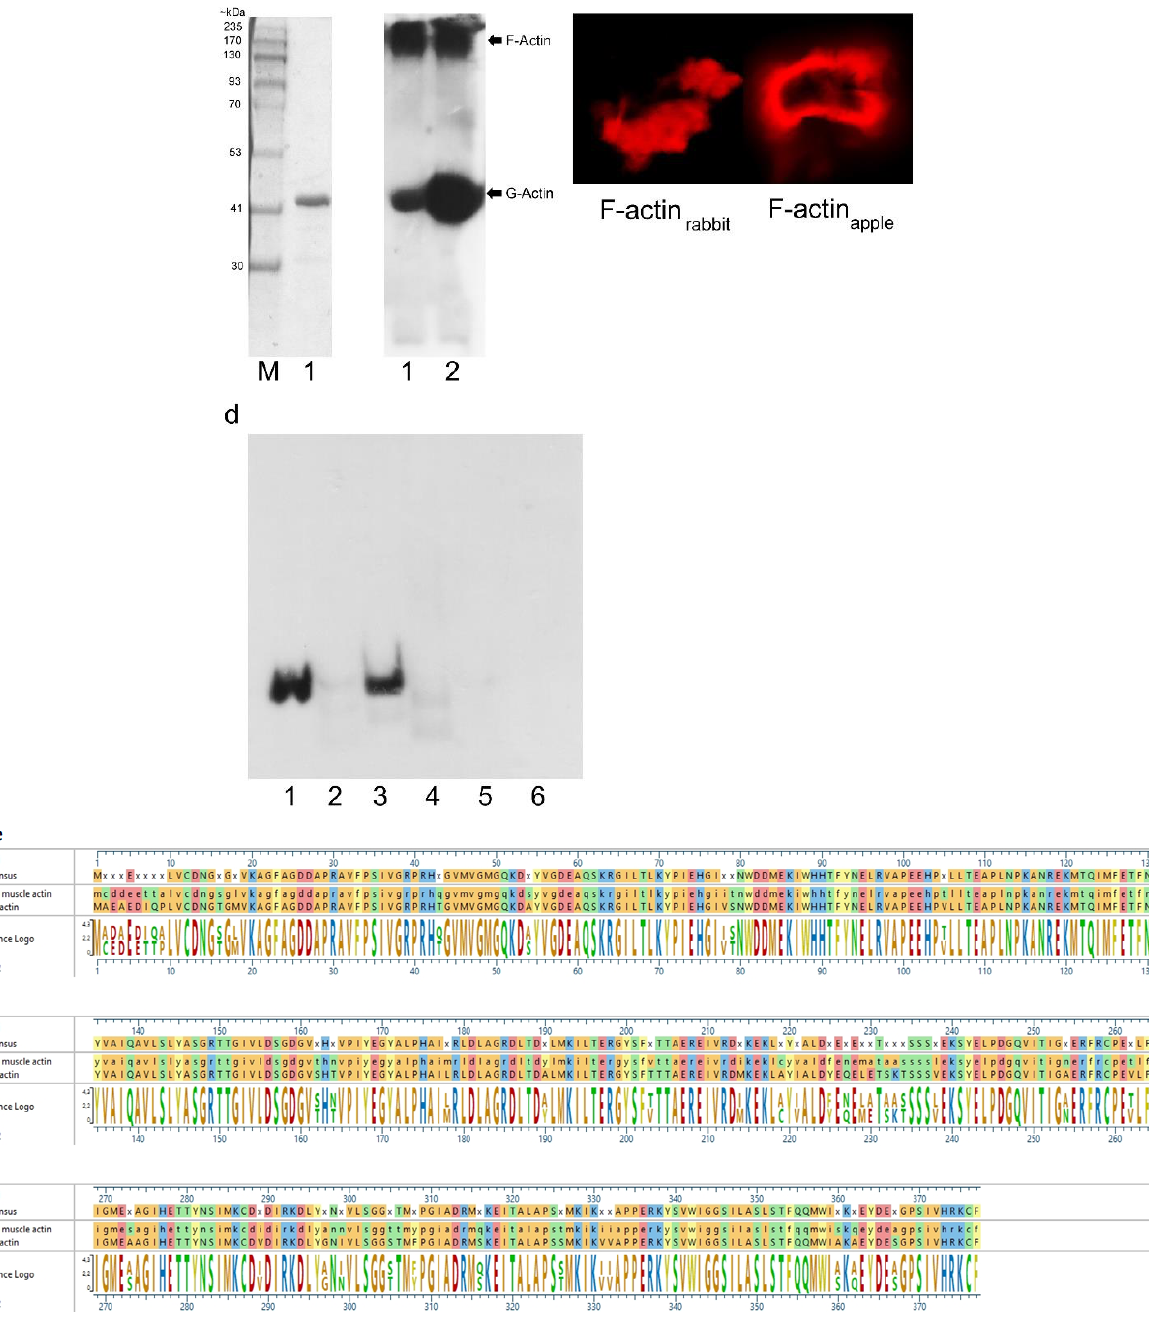
Figure 4. Co-sedimentation assay with recombinant actin apple , Imp- PM19 and ∆D3 -Imp-PM19-mu- tant. ( a ) Coomassie-stained SDS-PAGE of recombinant apple actin. M is a protein marker. 1 is re- combinant apple actin. ( b ) Western blot of recombinant actin apple . Recombinant actin apple (lane 1) and actin rabbit (lane 2, a positive control) were polymerized and subjected to SDS-PAGE. After blotting, the proteins were detected using anti-actin and anti-mouse-POD, respectively. ( c ) Labelling F-actins with Acti- stain™ fluorescent phalloidin 555 (Cytoskeleton, Inc). The labelled F-actins were visual- ized under a confocal microscope with a bandpass 575 – 615 nm filter. ( d ) Co-sedimentation assay. Imp- PM19 and ∆D3 -Imp-PM19 mutant were incubated with F-actin apple and F-actin rabbit . After height speed centrifugation, the protein pellets were subjected to SDS-PAGE, and a western blot was per- formed using anti-His and anti-mouse-POD, respectively. Lane 1 and 2 are co-sedimented Imp- PM19 (1) and ∆D3 -Imp-PM19-mutant (2) with F-actin rabbit . Lane 3 and 4 are co-sedimented Imp- PM19 ( 3) and ∆D3 -Imp-PM19-mutant (4) with recombinant F-actin apple . Lane 5 and 6 are BSA (neg- ative controls) co-sedimented with Imp- PM19 (5) and ∆D3 -Imp-PM19-mutant (6). ( e ) An alignment